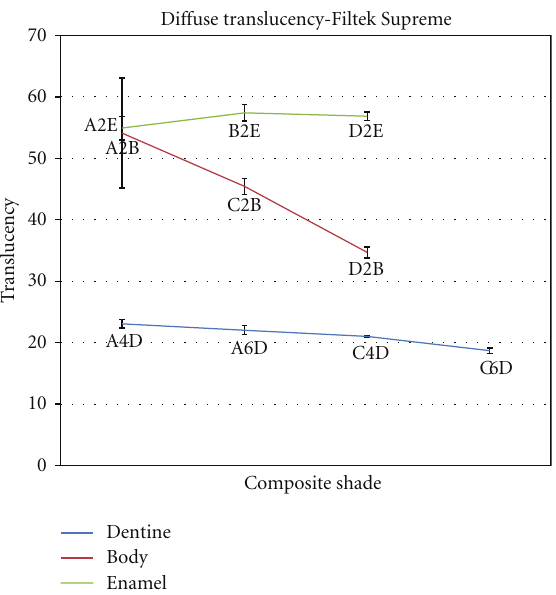
Figure 5: Mean di ff use translucency for di ff erent shades of Filtek Supreme composite